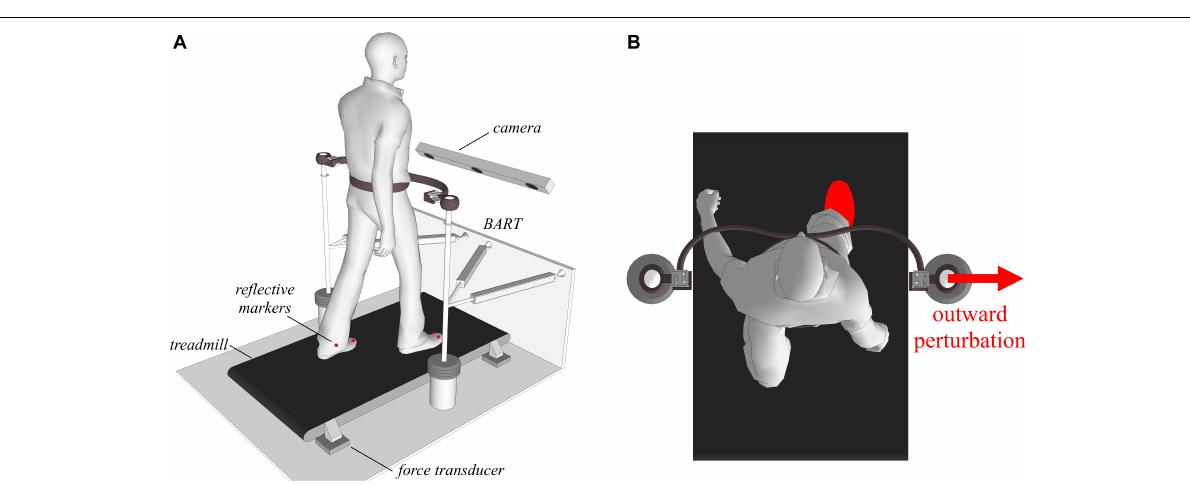
FIGURE 2 | Subjects walked on an instrumented treadmill, while receiving pelvic perturbations through the BART device in inward and outward directions when entering the stance with either the left or the right leg. (A) A graphical illustration of the experimental setup. (B) A graphical illustration of an outward perturbation occurring at right heel